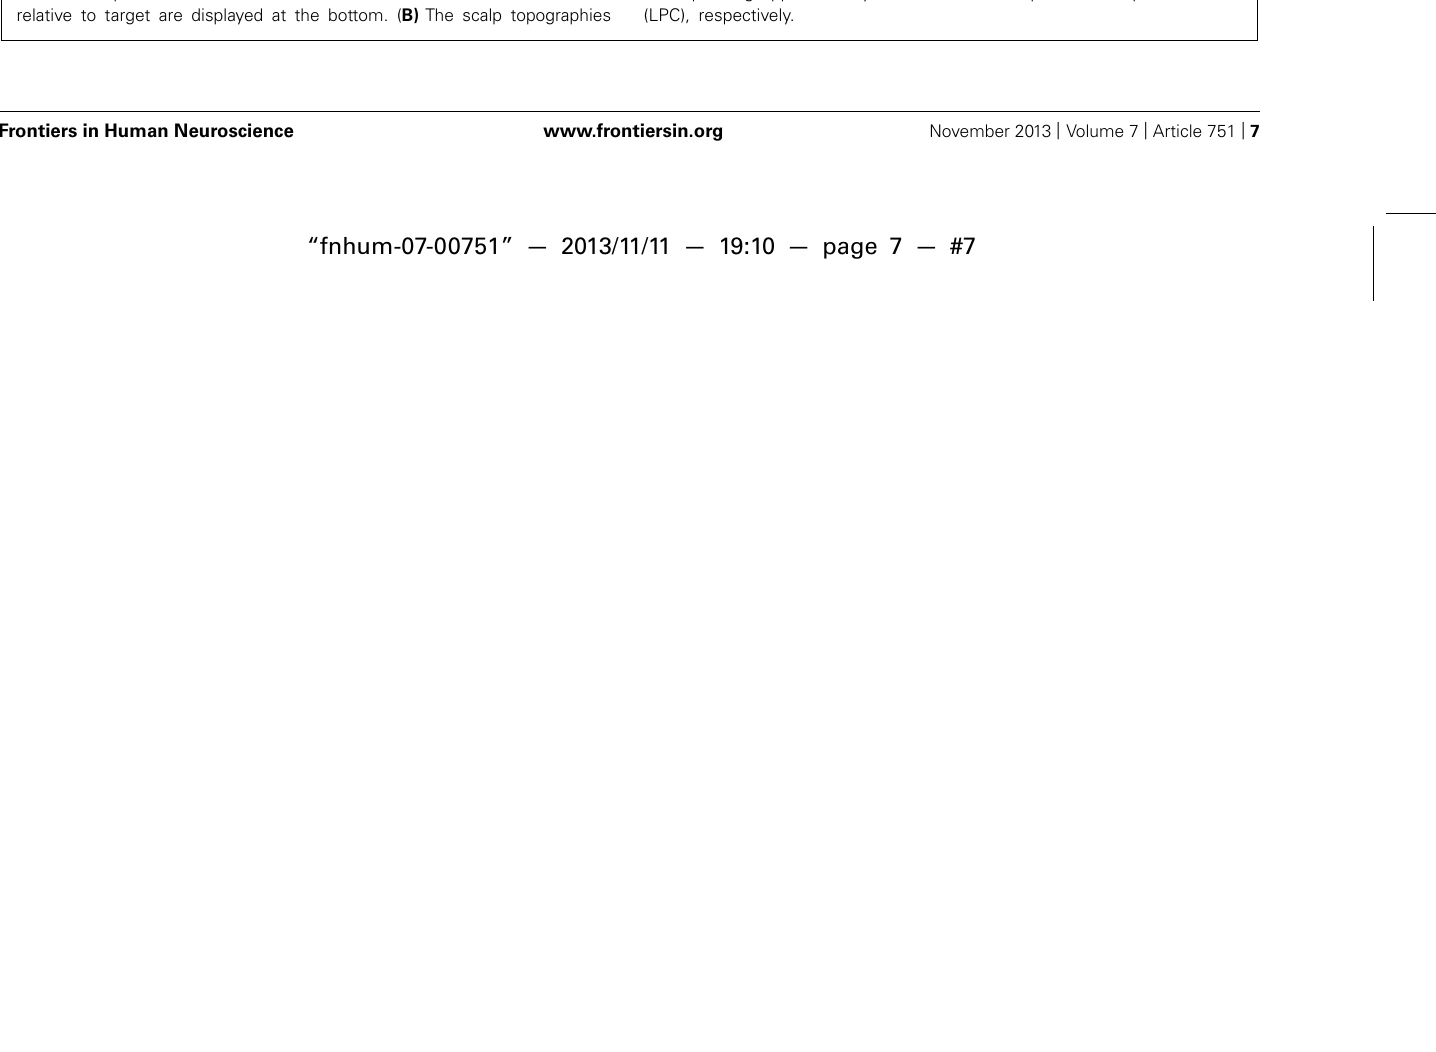
of TEPs in the go and stop trials for six participants in a contralateral-TMS session (two left 2 × 4 arrays) and for six participants in an ipsilateral-TMS session (two right 2 × 4 arrays). The bold white plus in each topography represents the TMS sites. The topographies are displayed only at 100 and 200 ms relative to TMS onset, corresponding approximately to N100 and later positive component (LPC),